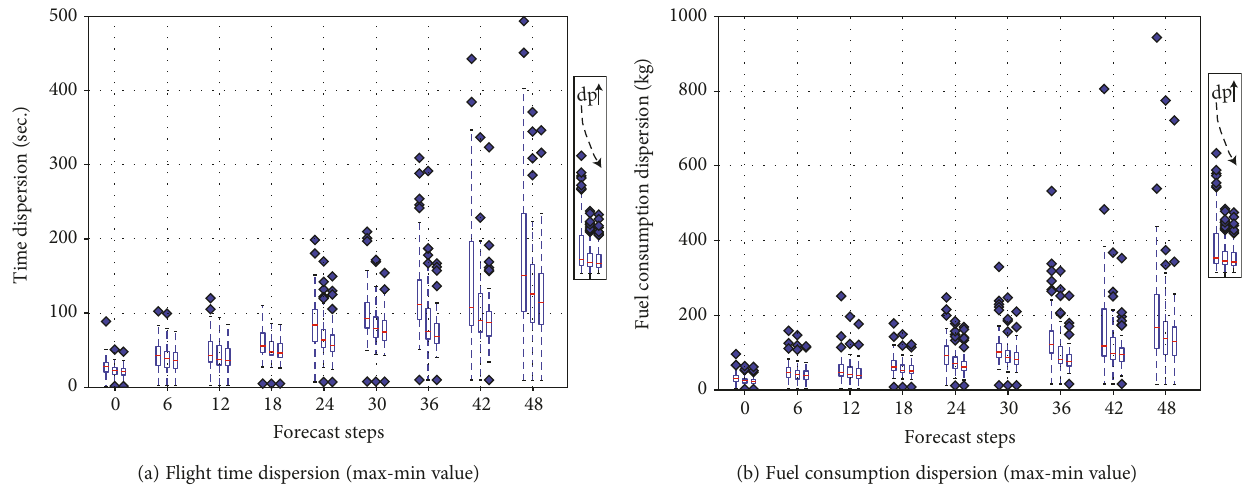
Figure 16: Aggregated dispersion boxplot multiple origin-destination (short